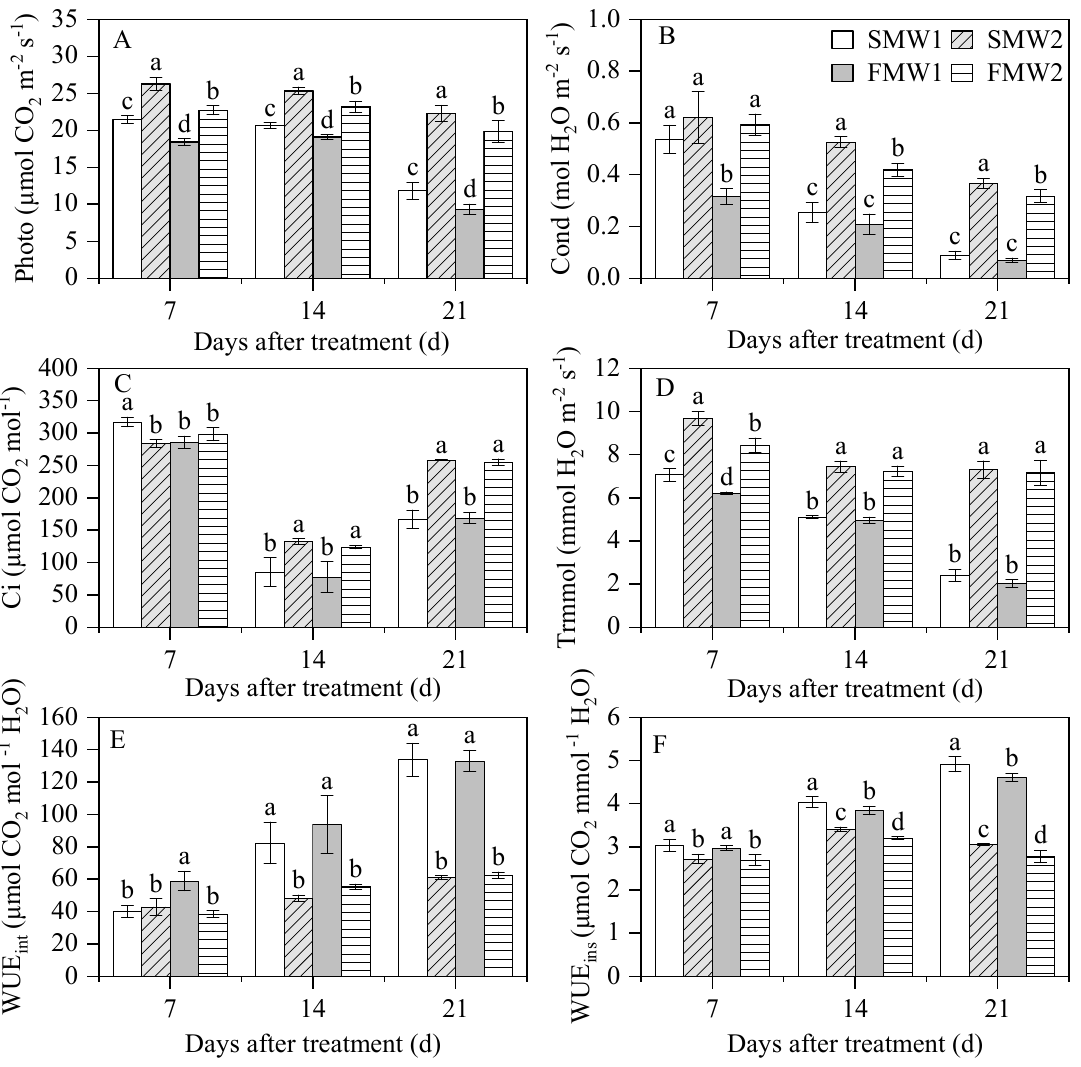
Figure 5. Effects of different treatments on the net photosynthetic rate (Photo) ( A ), stomatal conductance (Cond) ( B ), intercellular CO 2 concentration (Ci) ( C ), transpiration rate (Trmmol) ( D ), intrinsic water use e ffi ciency (WUE int ) ( E ), and instantaneous water use e ffi ciency (WUE ins ) ( F ) of tomato plants. Values are the mean ± SD (n = 3). Duncan’s multiple-range test was used to test for di ff erences among treatments at the p < 0.05 level. Di ff erent lowercase le tt ers above the columns indicate signi fi cant di ff erences among treatments within the same day.